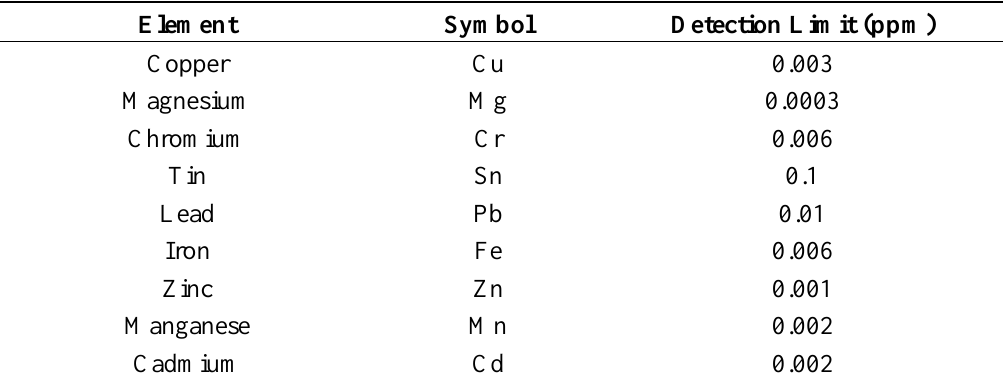
Table 5. Detection limits of the